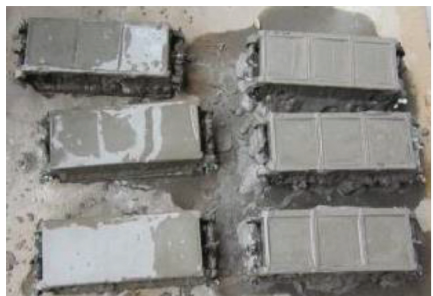
Figure 5: The preparation of test samples.